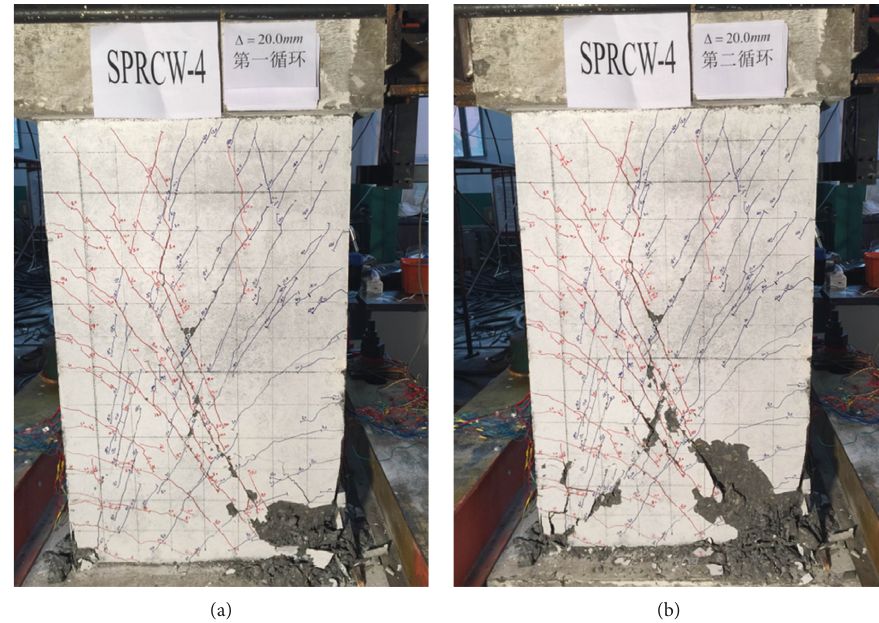
Figure 23: Diagram of cracks in the Δ � 20mm displacement cycle. (a) First cycle. (b) Second